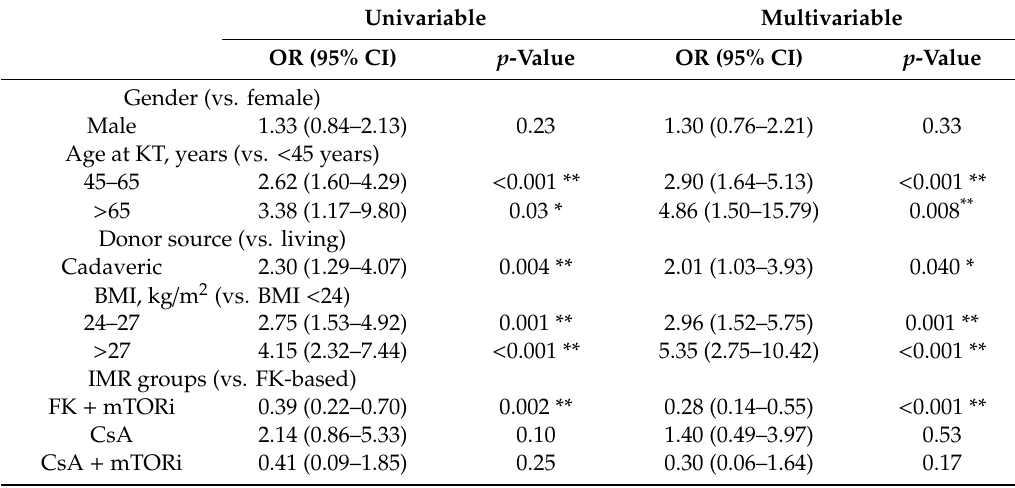
Table 3. Logistic regression analysis for risk factors for